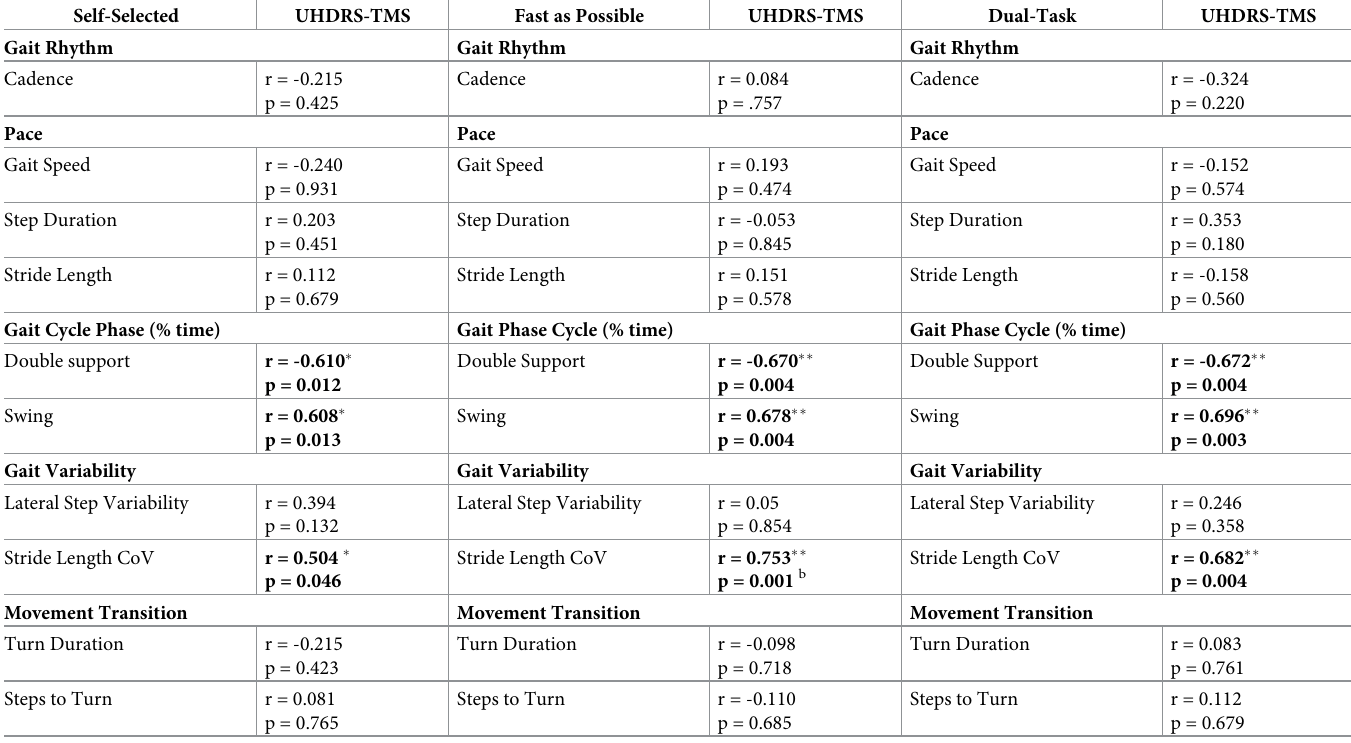
Table 3. Relationship between UHDRS-TMS and gait